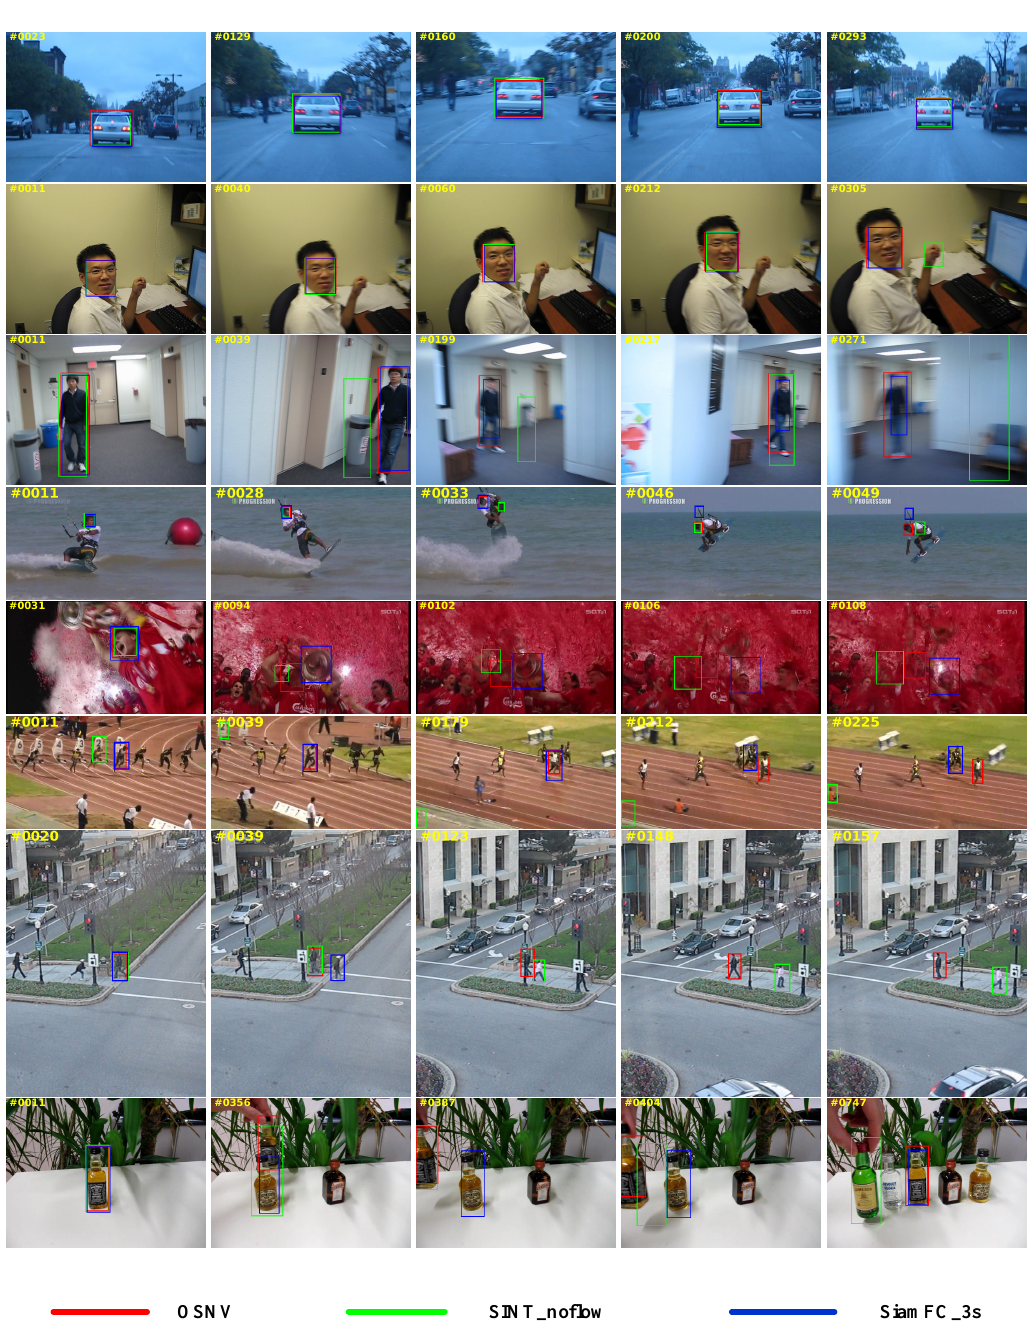
Figure 10. Qualitative performance of our proposed algorithm (OSNV), SINT_noflow, SiamFC_3s on eight challenging video sequences (from top to bottom rows are BlurCar, BlurFace, BlurBody, KiteSurf, Soccer, Bolt2, Human3a and